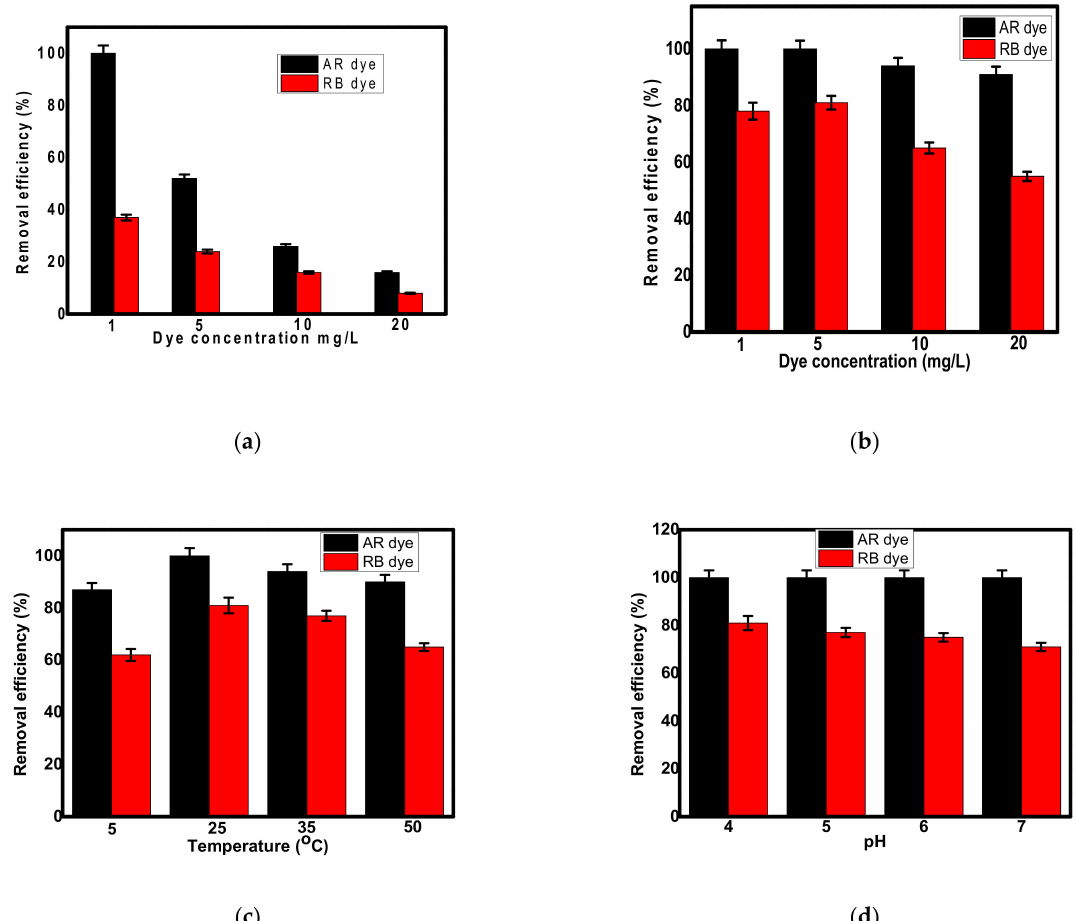
Figure 5. ( a ) Dye removal using inactivated laccase. ( b ) Dye concentration effect, ( c ) temperature effect and ( d ) pH effect on AR and RB removal over the Fe 3 O 4 -NH 2 @MIL-101(Cr)